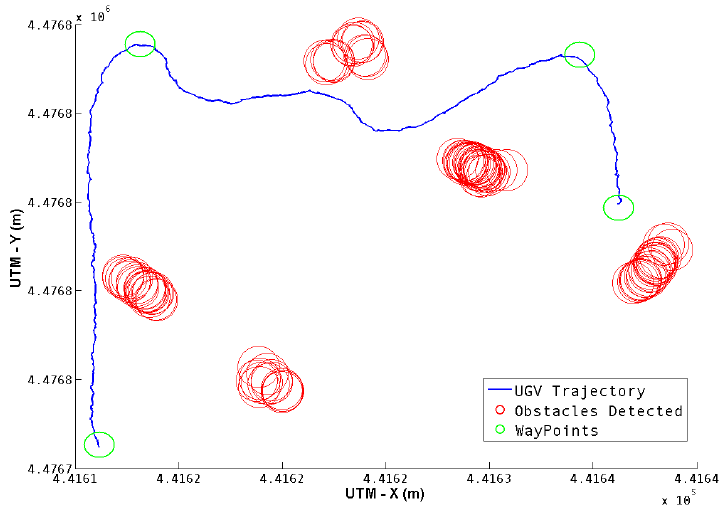
Figure 11. Second Test Trajectory. The blue line describes the UGV trajectory. The red circles represent the obstacles found in the pathway and the green circles are the way-points.